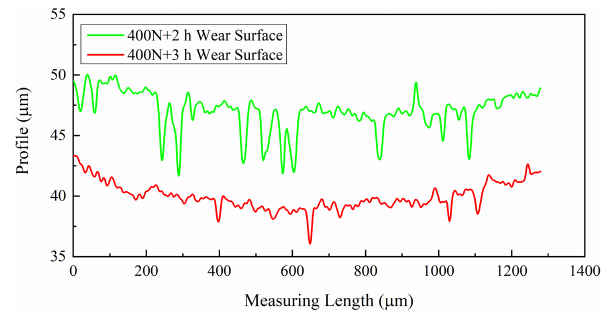
Figure 14. Profile curve under different lubrication conditions.